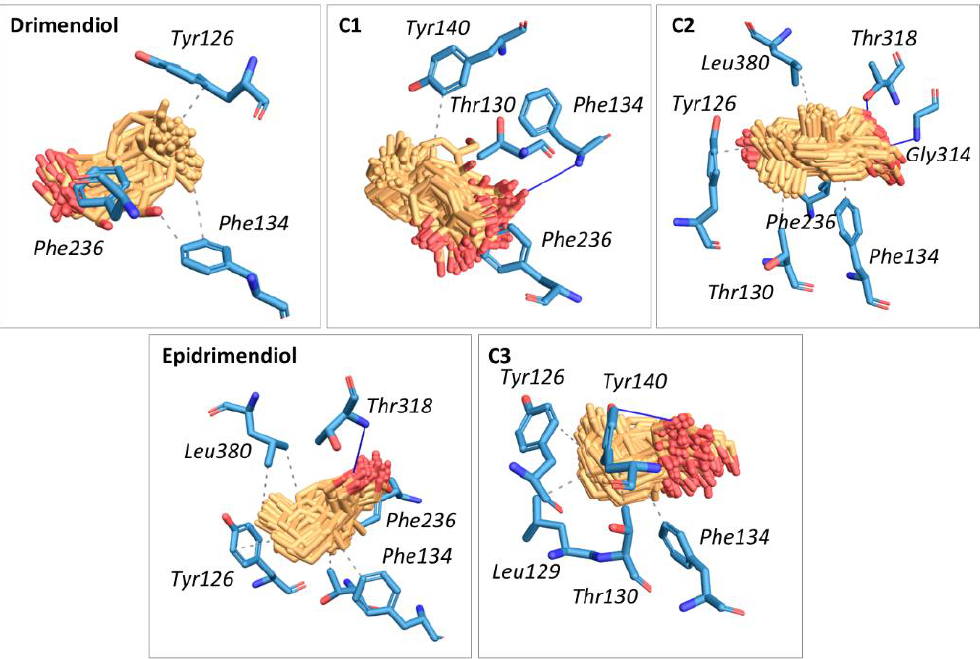
Figure 4. Schematic representation of the intermolecular interactions that are responsible for ligands’ binding to the binding pocket of lanosterol 14α -demethylase. Hydrogen bonds are displayed in bold lines. Hydrophobic interactions are displayed in dashed lines. Data were obtained from the analysis of protein-aligned 150 ns MD trajectories. The mobility of the ligand in each complex is displayed in the figure.